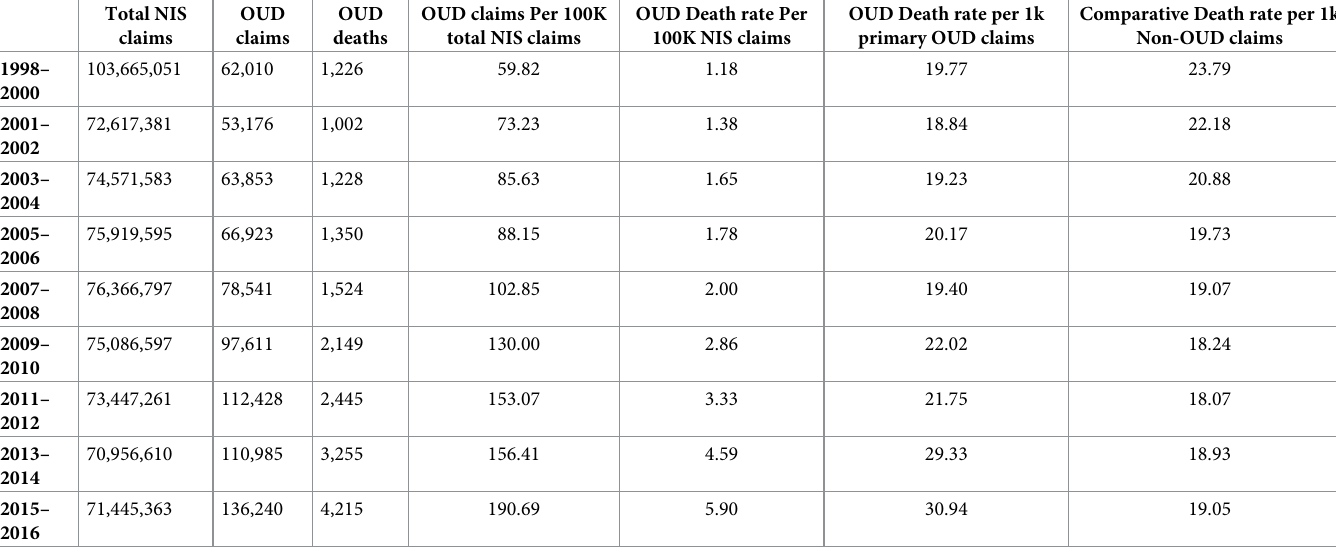
Table 3. Time-trends in OUD hospitalization and mortality rates from 1998 to 2016 and the comparative non-OUD mortality rates. Total NIS